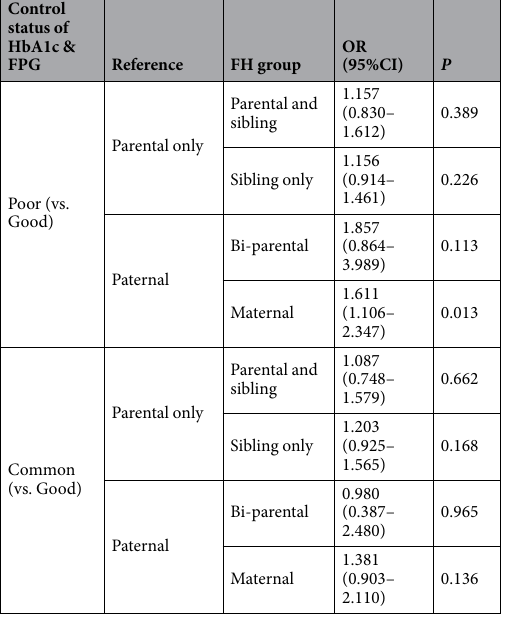
Table 4. Internal comparison of glycaemic control among type 2 diabetes patients with FH of diabetes. Adjusted for age, gender, education, smoking, drinking, antidiabetic treatment, duration of diabetes, spouse with diabetes, BMI and physical activity. OR: odds ratio; CI: confidence interval.